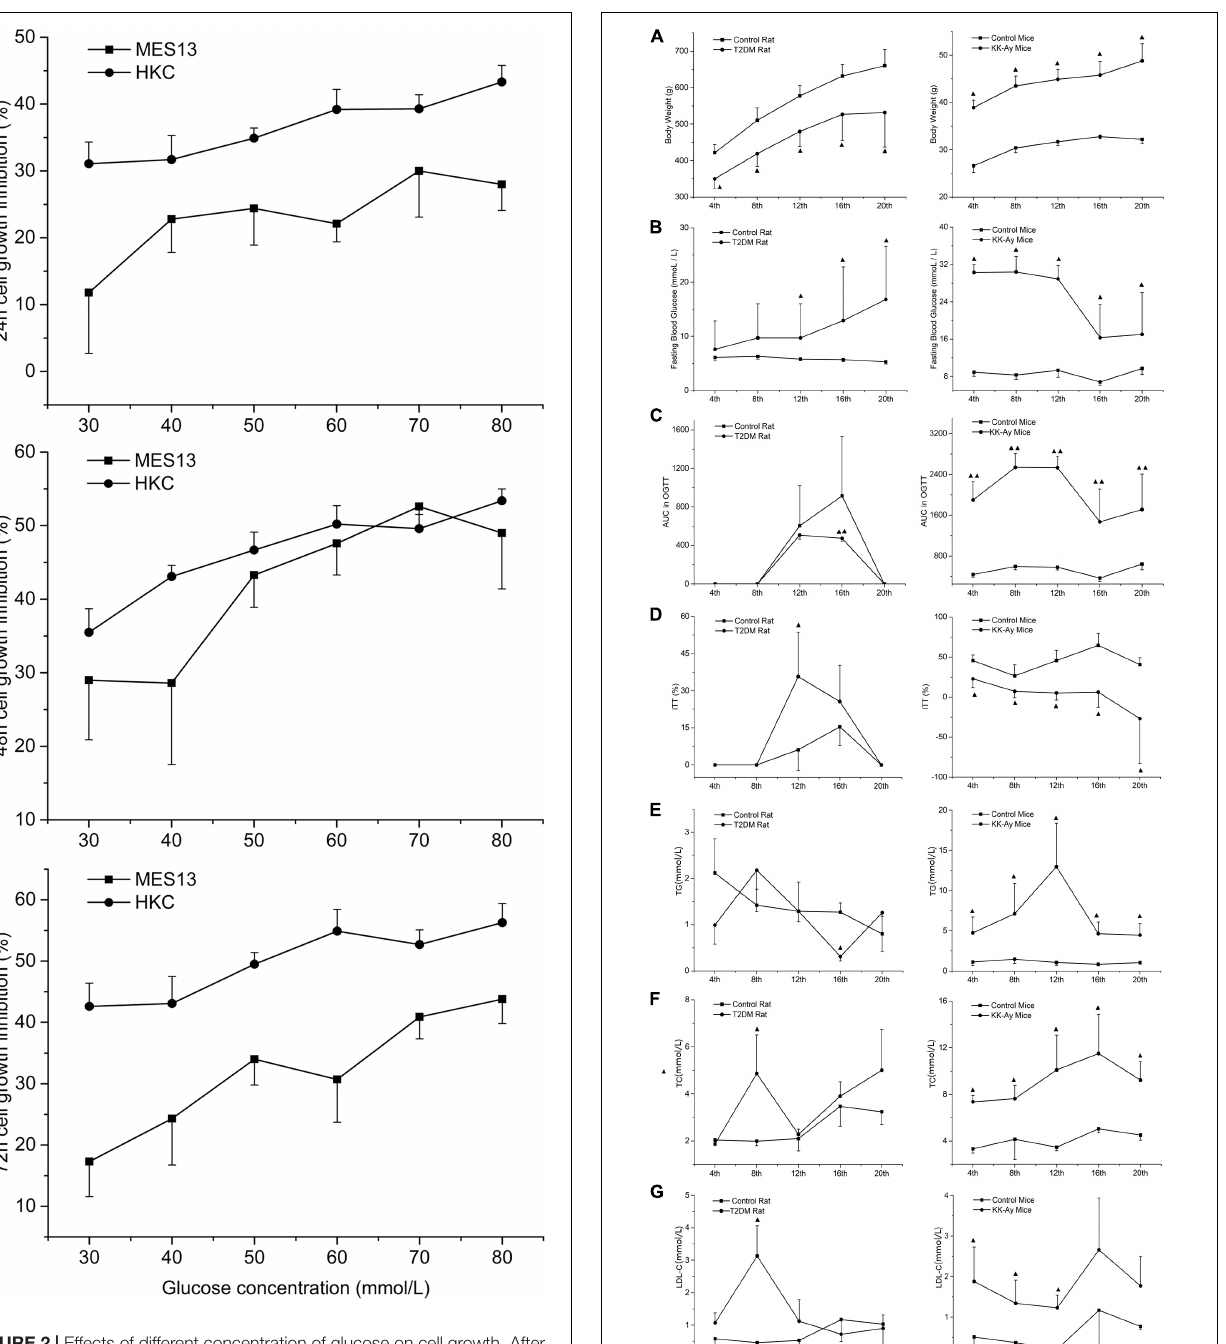
Frontiers in Cell and Developmental Biology | www.frontiersin.org